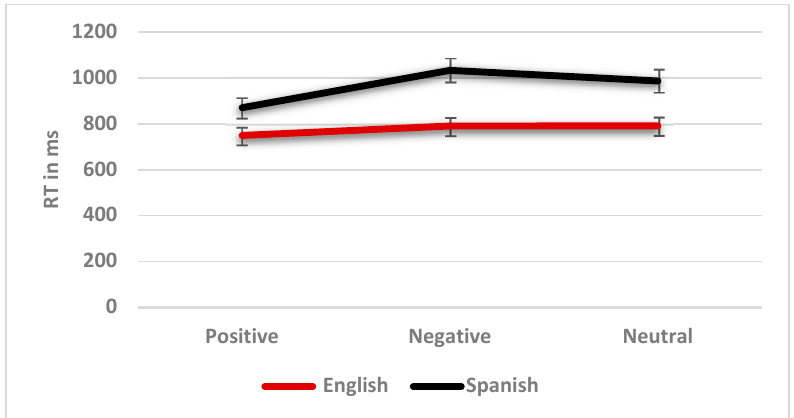
Figure 1. Mean RTs in milliseconds for English and Spanish positive, negative, and neutral words recorded in the LDT task. Error bars depict 95% confidence interval.